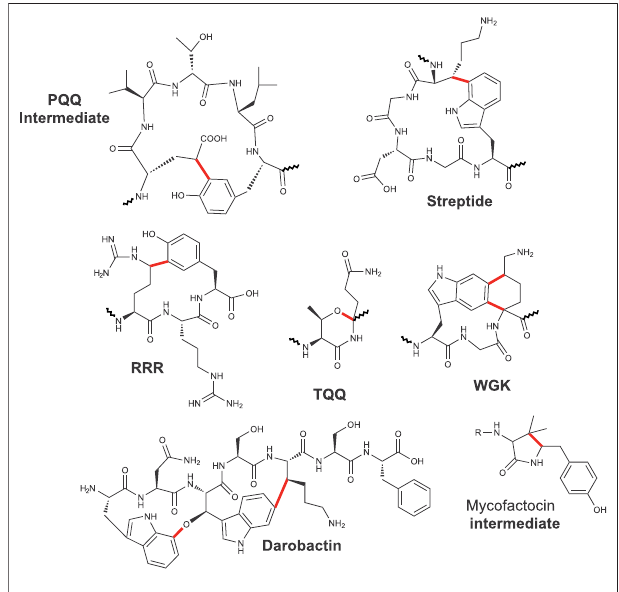
FIGURE 7 | Carbon – carbon, carbon – oxygen bonds and complex rearrangement catalyzed by radical SAM